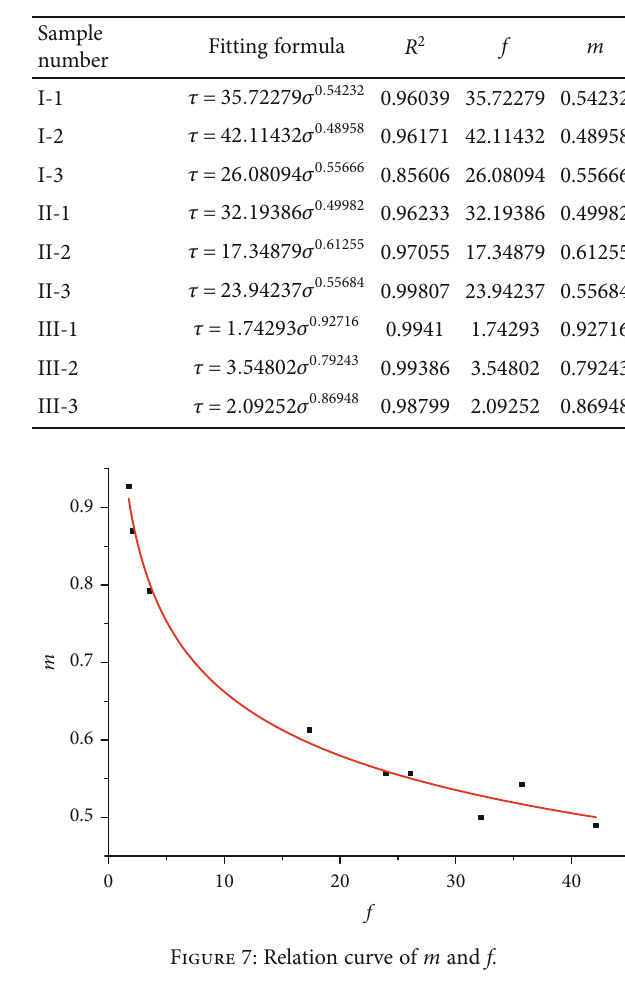
Table 4: Shear strength fi tting formula and related parameters of each sample.